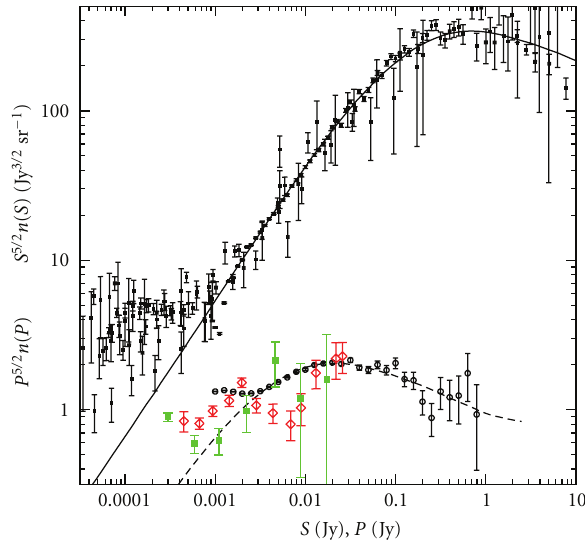
Figure 1: Di ff erential number counts at 1.4 GHz as a function of total intensity (upper points) and of polarized intensity (lower points: black empty circles from NVSS; red empty diamonds from DRAO Planck Deep Fields; green squares from ATLBS). The continuous curve represents the number counts of AGNs from [44], whereas the dotted curve is obtained by the previous counts and assuming a constant fractional polarization of 3.3% for all ERS.